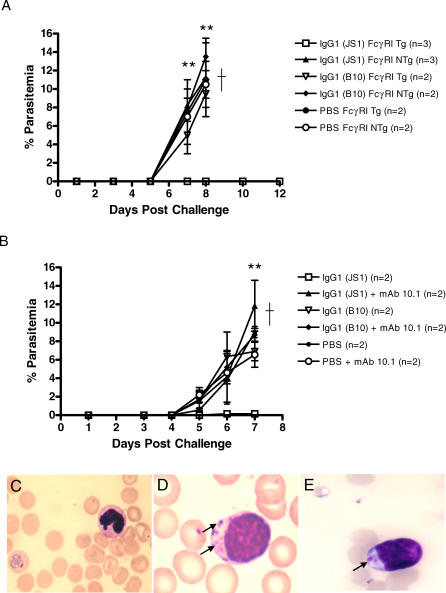
Course of a P. falciparum MSP119 Transgenic P. berghei Infection in Mice(A) Groups of 2–3 FcγRI transgenic (Tg) or nontransgenic (NTg) littermates were injected i.p. with a total dose of 1.5 mg fully human anti–P. falciparum MSP119 IgG1 (JS1), an irrelevant human IgG1 (B10) recognizing MSP119 from P. yoelii or PBS. Similar results were obtained in two independent experiments. **Only groups of mice given JS1 in the FcγRI Tg were significantly different to all the other control groups with a p < 0.01. †, death of mice.(B) Repeat experiment in FcγRI Tr animals using a lower total dose (0.75 mg) of JS1. Coadministration of the blocking mAb 10.1 specific for the IgG1 binding site on human FcγRI abrogates the protection mediated by the passively administered JS1 antibody. Each point represents the geometric mean parasitemia of mice in each group at the time after i.p. challenge with 5,000 parasitized erythrocytes. Only those animals receiving the fully human anti–P. falciparum MSP119 IgG1 Ab in a human FcγRI background survived an otherwise lethal infection; all the mice in the other groups with high parasitemias were killed on either day 7 or 8. Similar results were obtained in two independent experiments. **Only groups of mice given JS1 in the FcγRI Tg were significantly different to all the other control groups with a p < 0.01. †, death of mice.(C–E) ×100 magnification of Giemsa-stained smears of blood taken from control animals (C) and FcγRI Tg animals treated with JS1 (D and E). Note the presence of phagocytosed merozoites within the cytoplasm of cells displaying mononuclear morphology (arrow).